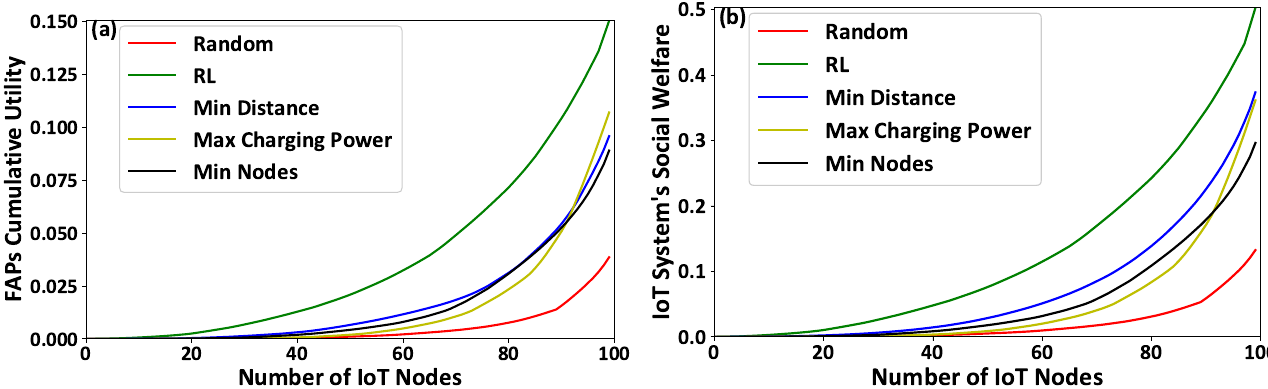
Figure 7. ( a ) FAPs’ cumulative utility and ( b ) the overall IoT system’s social welfare — A Comparative Evaluation.